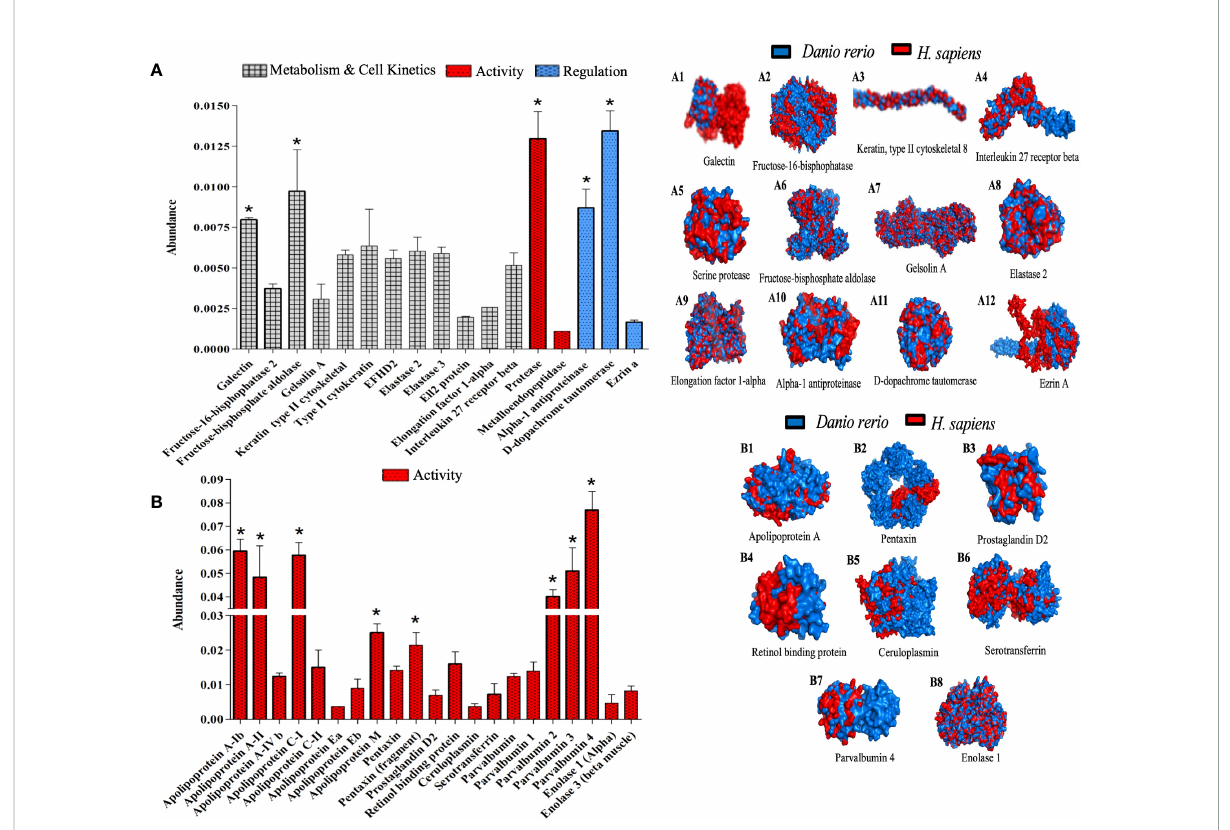
FIGURE 9 Activated polymorphonuclear leukocytes proteins orchestrate crucial in fl ammatory mechanisms 4h after l -CGN injection in zebra fi sh. (A) The abundance of key proteins of cellular metabolism and kinetics, activity, and regulation is displayed. (A 1-12) Representation of the structural 3-D proteins in zebra fi sh (blue) plasma overlapping with their predicted Homo sapiens (red) homologous structures. Several inducers, mediators, and regulators of in fl ammation were reconstructed (E.g., Elongation factor 1-alpha, Galectin, or Fructose-bisphosphate aldolase, respectively). Note the presence and high abundance of Ezrin A in zebra fi sh. This protein is widely used to predict the strength of the in fl ammatory response in vertebrates. (B) The abundance of the main proteins related to the acute phase of in fl ammation triggered by the l -CGN injection in zebra fi sh is presented. Note the marked increase in activity that was recorded in the apolipoprotein (classes: A, C, E, and M) and the parvalbumin isoforms (1, 2, 3, and 4). (B 1-8) Major circulatory proteins of the acute phase of in fl ammation are triggered by the main PMN cell family (Neutrophils, Eosinophils, Basophils, and Mast cells). The values in the graphs are expressed as relative abundance of the sample average (n = 4). The structural analysis of the proteins is described in the methodology. Abundance increases denoted by asterisks. Data are representative of two repeated trials in which all samples were run in triplicate (Student ’ s t test, p < 0.05). Error bars indicate